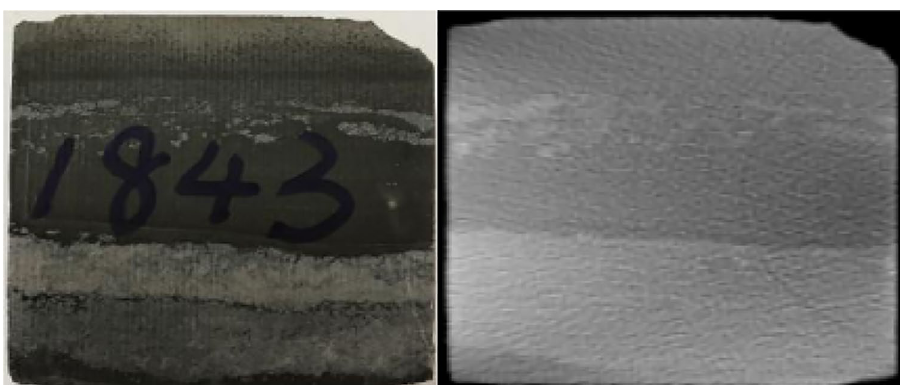
Fig. 7 Inter-salt shale